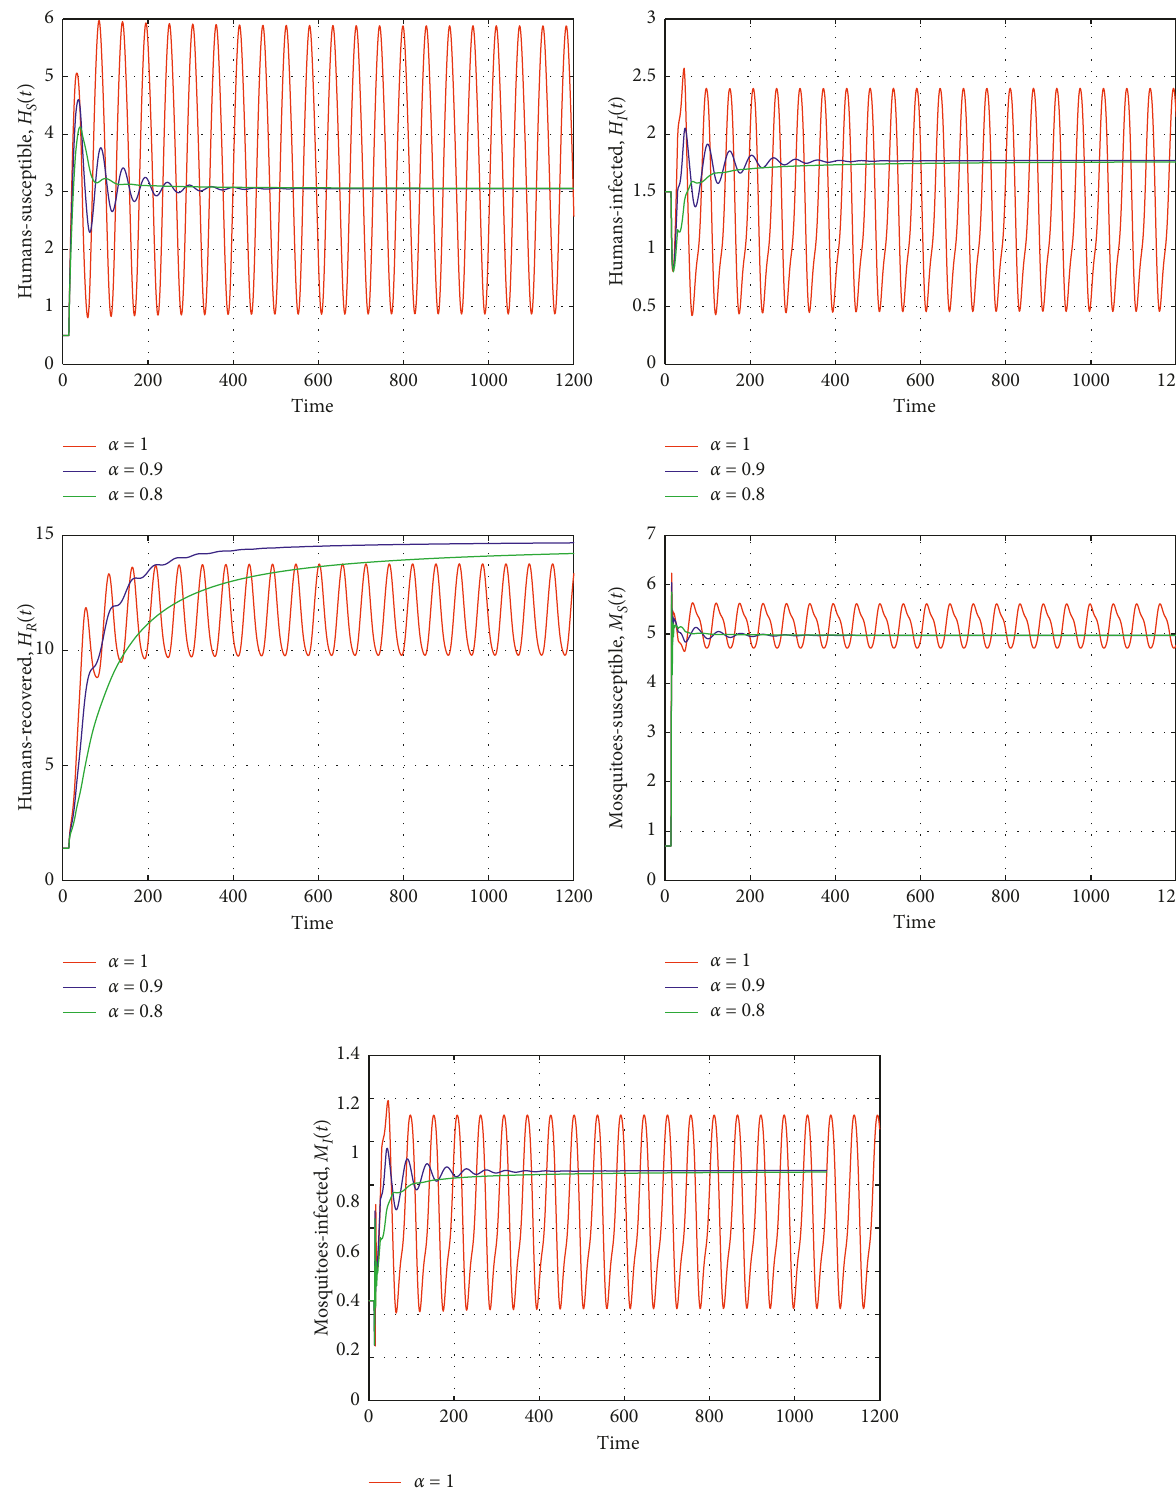
Figure 3: State trajectories for model (5) for α � 1 , 0 . 9 , and 0 . 8 and τ equilibrium point is unstable (red trajectory) for (5). However, for τ